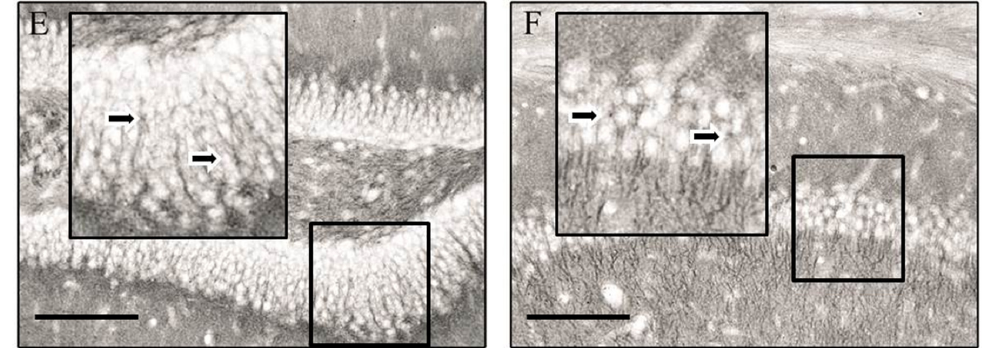
Figure 1. PSD ‐ 95 expression in the C57BL/6 PKU mouse. ( A ) An overview picture of the PSD ‐